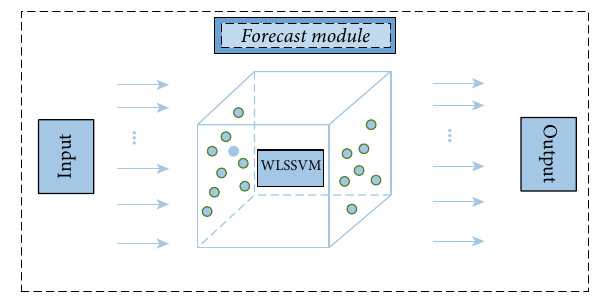
Figure 7: WLSSVM prediction